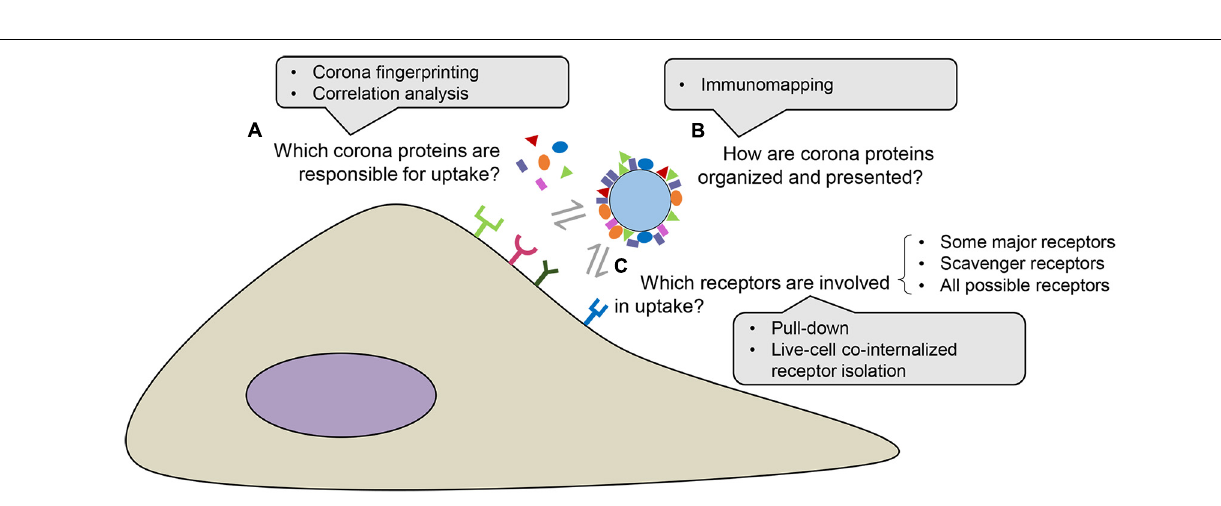
Frontiers in Bioengineering and Biotechnology |